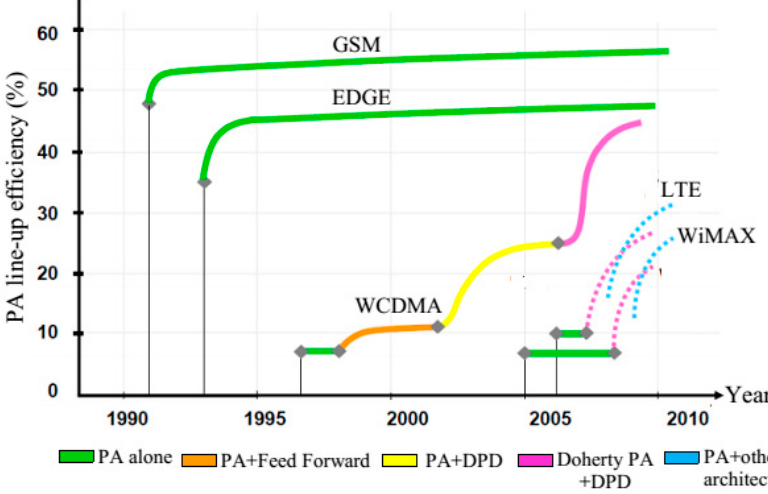
Figure 5. PA efficiency of different cellular communication generations [34].